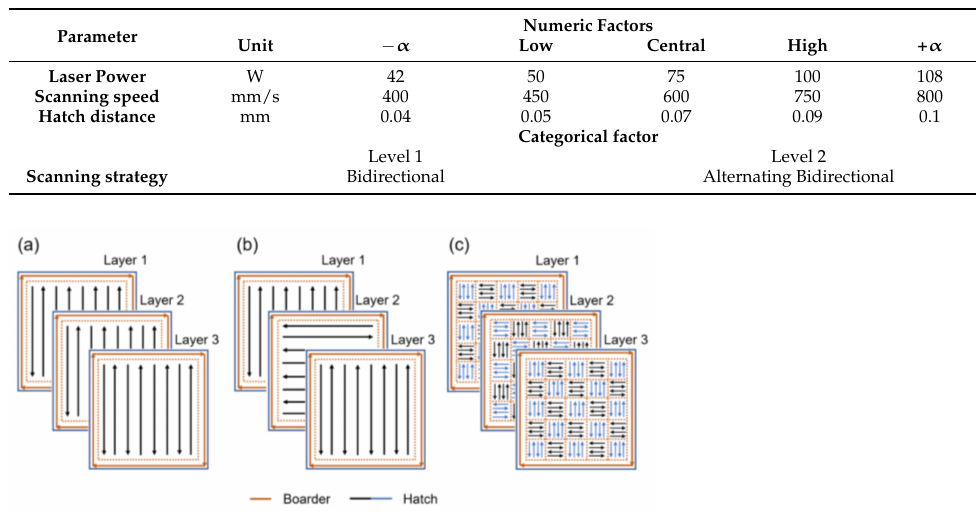
Table 2. Input ranges of process parameter used in CCD.